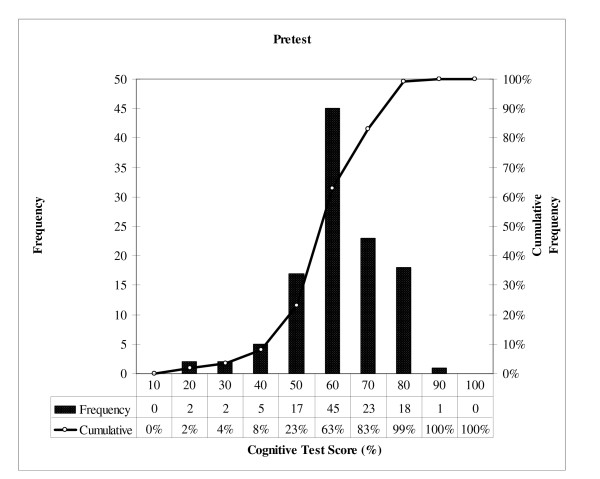
Frequency of scores for the cognitive test pretest scores.